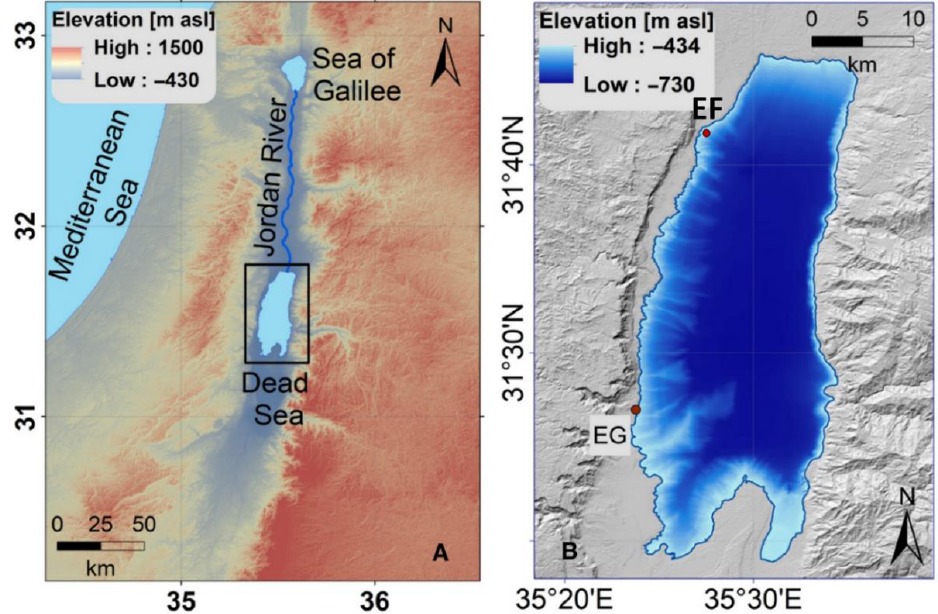
Figure A1. Study site: ( A ) regional map; ( B ) Dead Sea map. The study sites are located on the western Dead Sea coast: Ein Gedi borehole (EG) and Ein Feshkha buoy (EF).